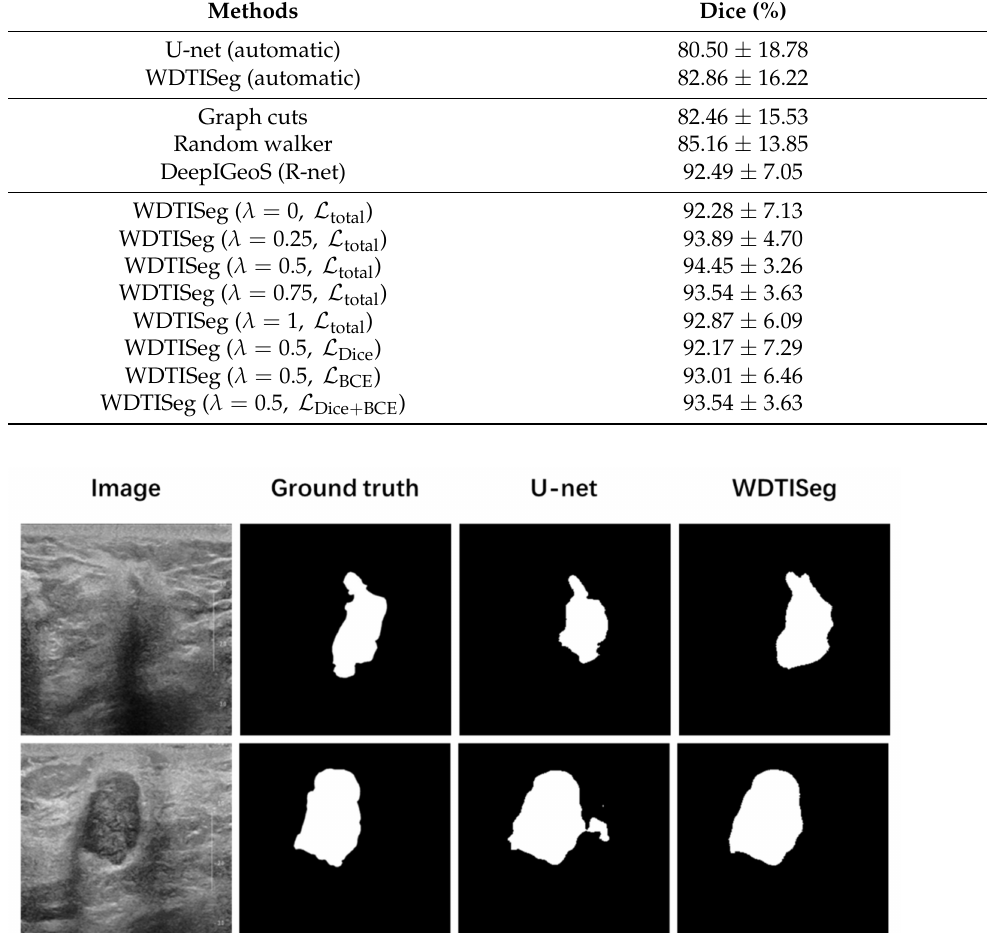
Figure 5. The automatic segmentation results of U-net and